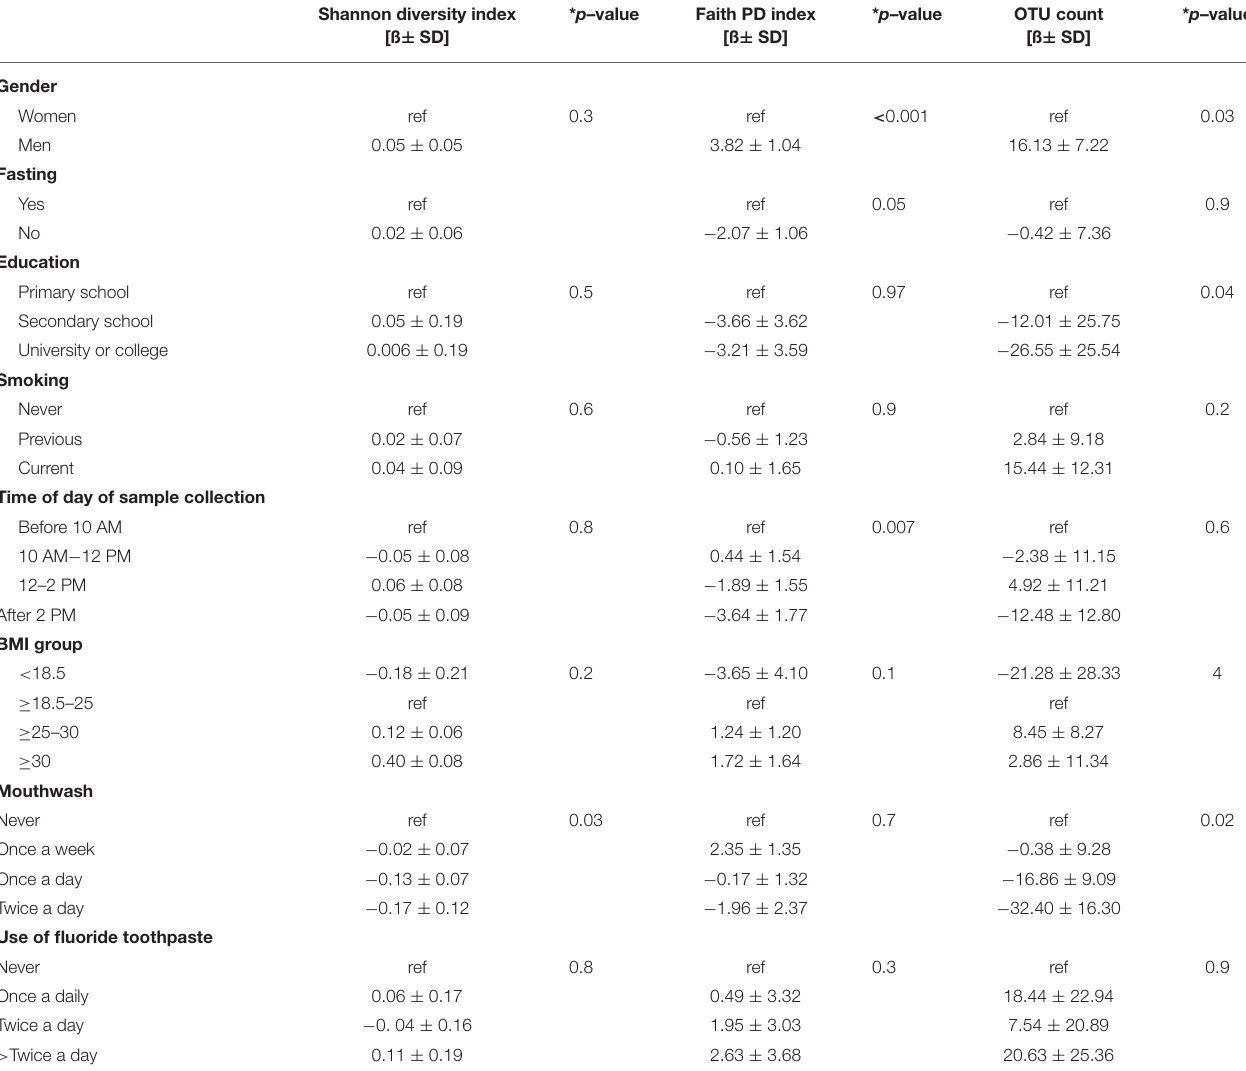
TABLE 3 | Linear regression modeling for change (ß) in alpha-diversity indices (Shannon diversity index, Faith’s PD, and OTU count) by population